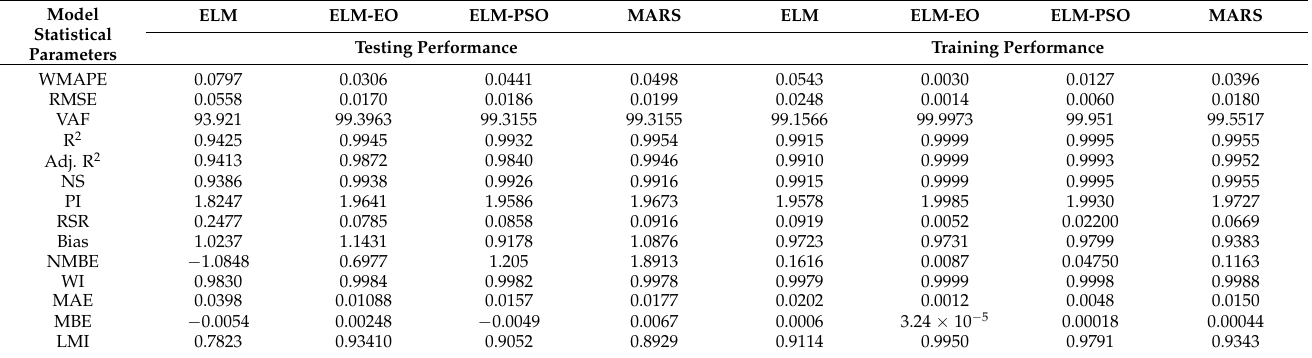
Table 6. Values of the performance